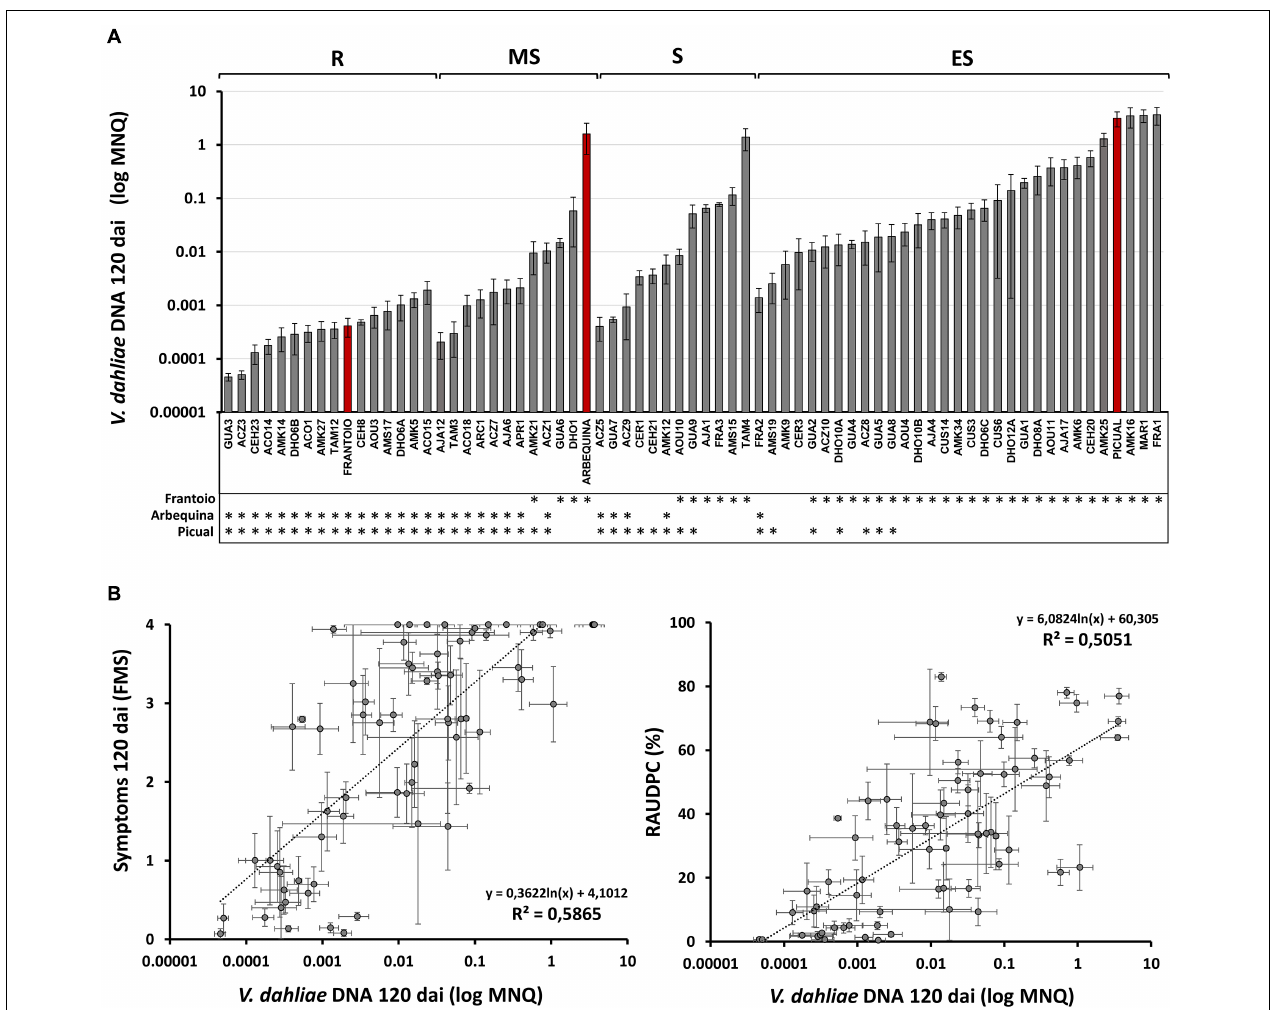
FIGURE 5 | (A) Mean Normalized Quantity (MNQ) of Verticillium dahliae DNA of wild olive genotypes evaluated at 120 days after inoculation (dai) with the V. dahliae defoliating isolate VD117. Red bars represent cvs. Frantoio, Arbequina, and Picual as reference cultivars of resistant, moderately susceptible, and extremely susceptible genotypes, respectively, according to the resistance level described by López-Escudero et al. (2007). Asterisks indicate significant differences with cvs. Frantoio, Arbequina, and Picual, respectively. (B) Scatter plots including regression line, regression equation and coefficient of determination ( R 2 ) for the relationships between the Mean Normalized Quantity (MNQ) of V. dahliae DNA and the Final Mean Severity (FMS) (left) or the RAUDPC (right) at 120 dai. Results are the mean of 12 plants per assay, or 24 plants for those genotypes repeated in two different assays. Error bars in two dimensions indicate the standard error of the